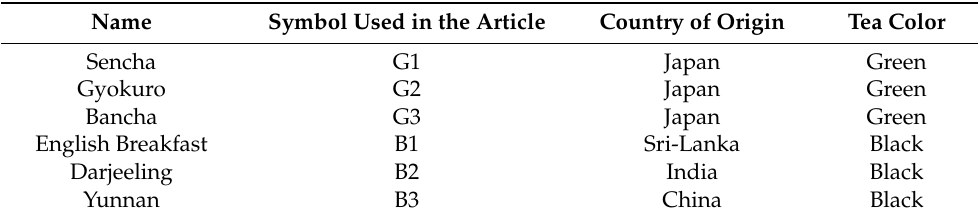
Table 7. List of tea brands selected for laboratory analyses.